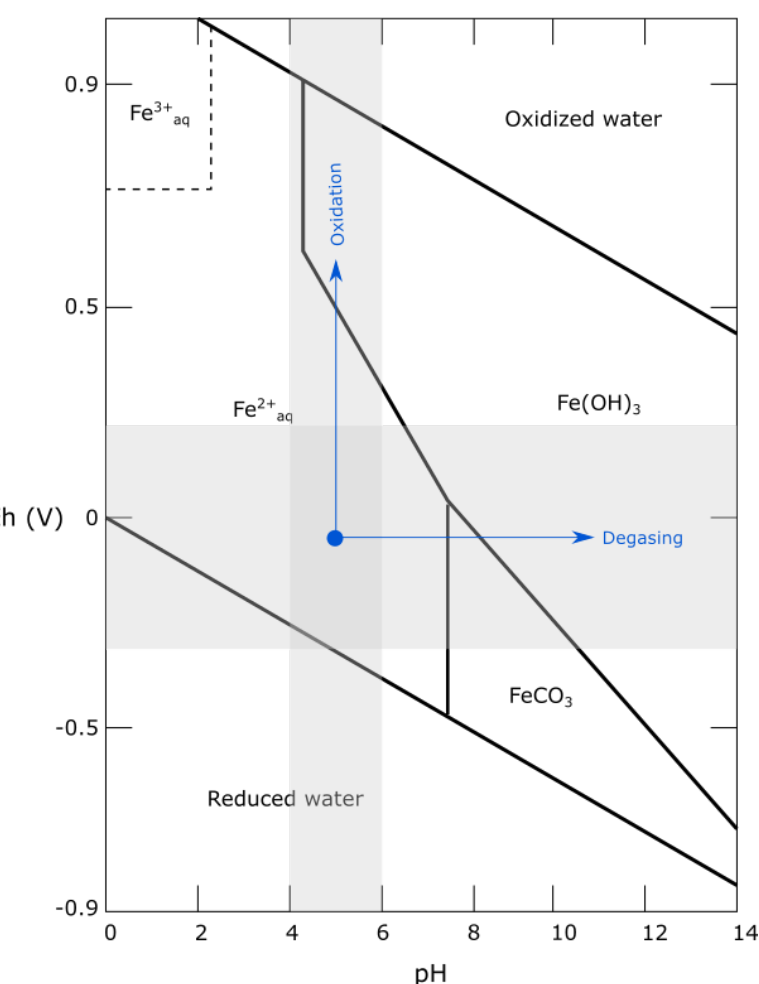
Figure 11. Eh-pH diagram ruling redox equilibria associated with iron species in the presence of CO 2 . Solid lines represent aqueous/solid boundaries whereas dashed lines represent aqueous/aqueous boundaries. The grey areas represent the pH and Eh conditions prevailing in groundwater in the study areas. The figure shows that when reaching the surface, the combined groundwater oxidation and CO 2 degassing lead to the formation and precipitation of Fe(OH) 3 (mostly under the form of goethite) (Modified form